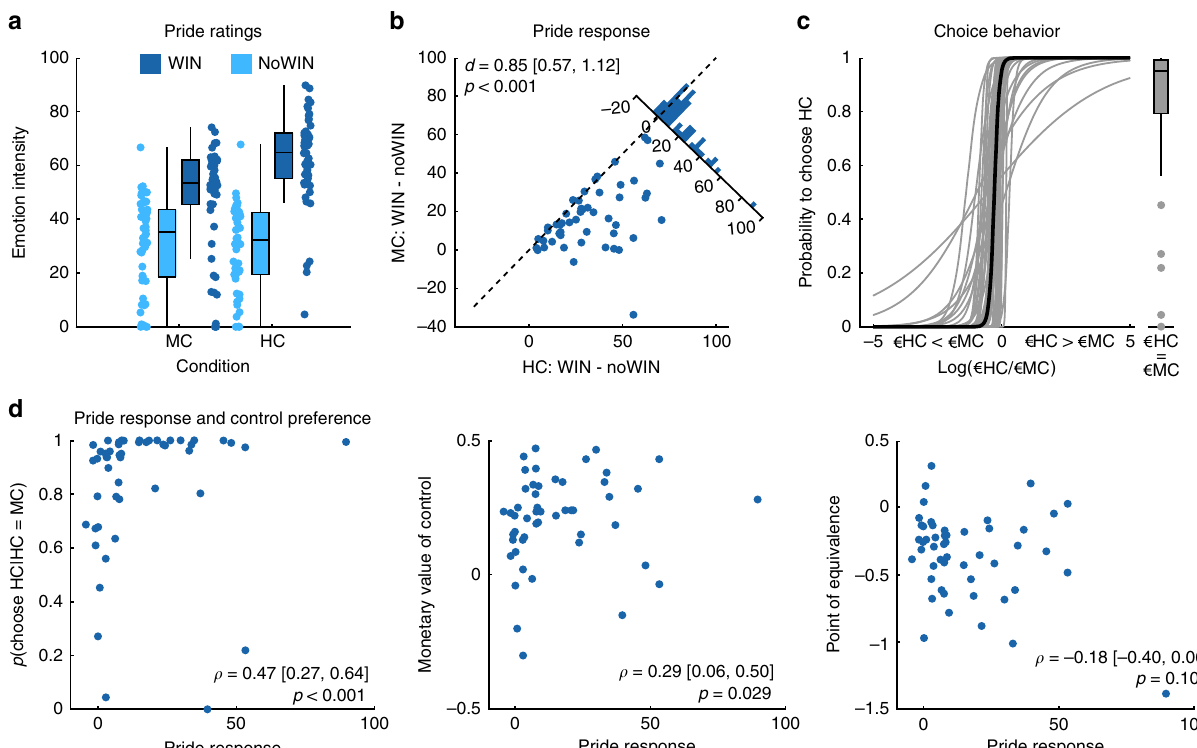
Fig. 7 The experience of pride in response to high control affects subjective value of choices. a Pride ratings for study 3, separate for high and low control, as well as outcome valence. b Pride reactivity to WIN vs noWIN outcomes, separately for HC ( x -axis) and MC ( y -axis). Histogram depicts difference between HC and MC. d = Cohen ’ s d . Values in brackets represent lower and upper bound of 90% con fi dence interval for d . c Probability to choose HC in choice task of study 3 as a logistic function of log-transformed relative option values (log( € HC/ € MC)). More positive values on the horizontal axis indicate higher monetary value of HC relative to MC. Thin gray lines represent individual participants ’ choice functions. Thick black line represents hypothetical choice behavior based on sample medians for β 0 and β 1 . Boxplot represents participant ’ probabilities to choose HC, given that both options have equal values. d Relationship of pride response and choice behavior in study 3. ρ = Spearman ’ s rho. Values in brackets are lower and upper bound of 90% con fi dence interval for rho . p -values in bottom row are one-sided and FDR-corrected. The center line of boxplots depicts the median, the upper, and lower box borders are the 25th and 75th percentile, and the length of the whiskers is 1.5 times the interquartile range. Source data are provided as a Source Data fi